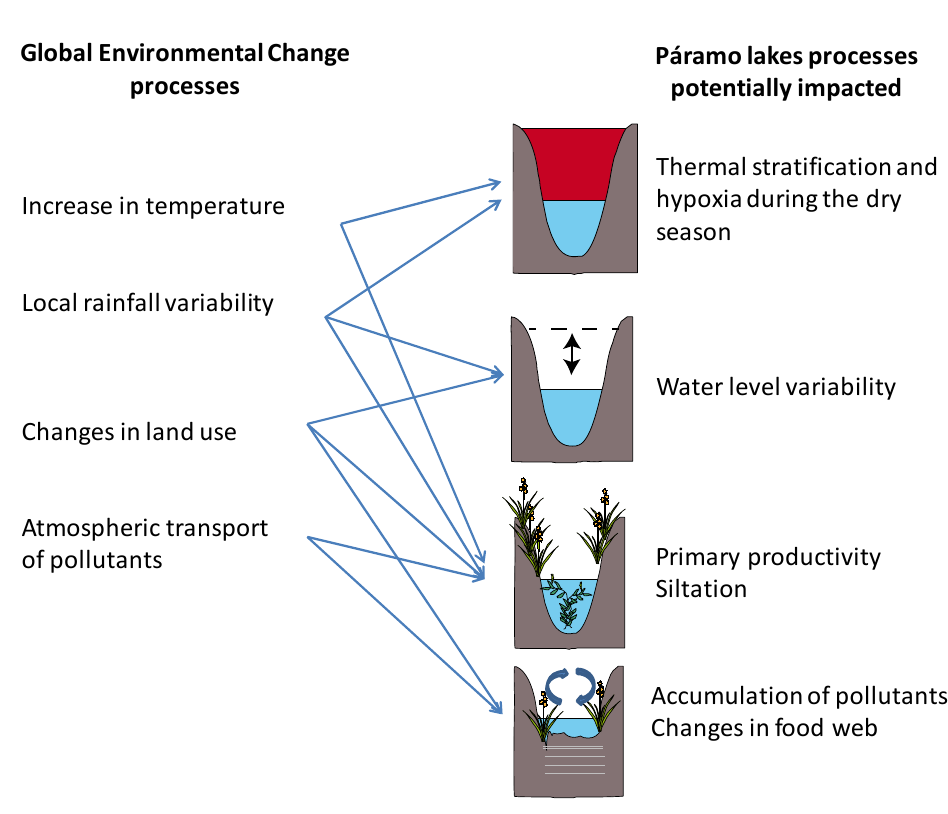
Figure 6. Conceptual sketch of the potential effects of global change on páramo lakes (Arrows indicate drivers ( left ) enhancement of the processes ( right ).